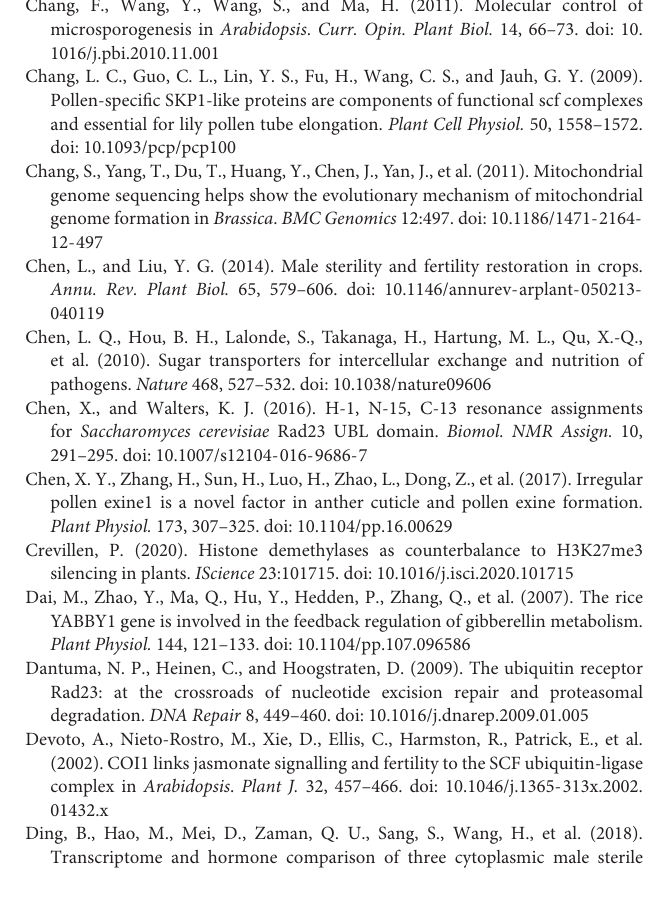
Supplementary Table 1 | Primers used in this study. Supplementary Table 2 | Primers for 32 known protein-coding genes. Supplementary Table 3 | Gene annotation of 99.75 kb DNA fragment. Supplementary Table 4 | GO annotation of DEGs. Supplementary Table 5 | KEGG pathway annotation of DEGs. Supplementary Table 6 | DEGs related to pollen and anther development. Supplementary Table 7 | DEGs selected for RT-qPCR